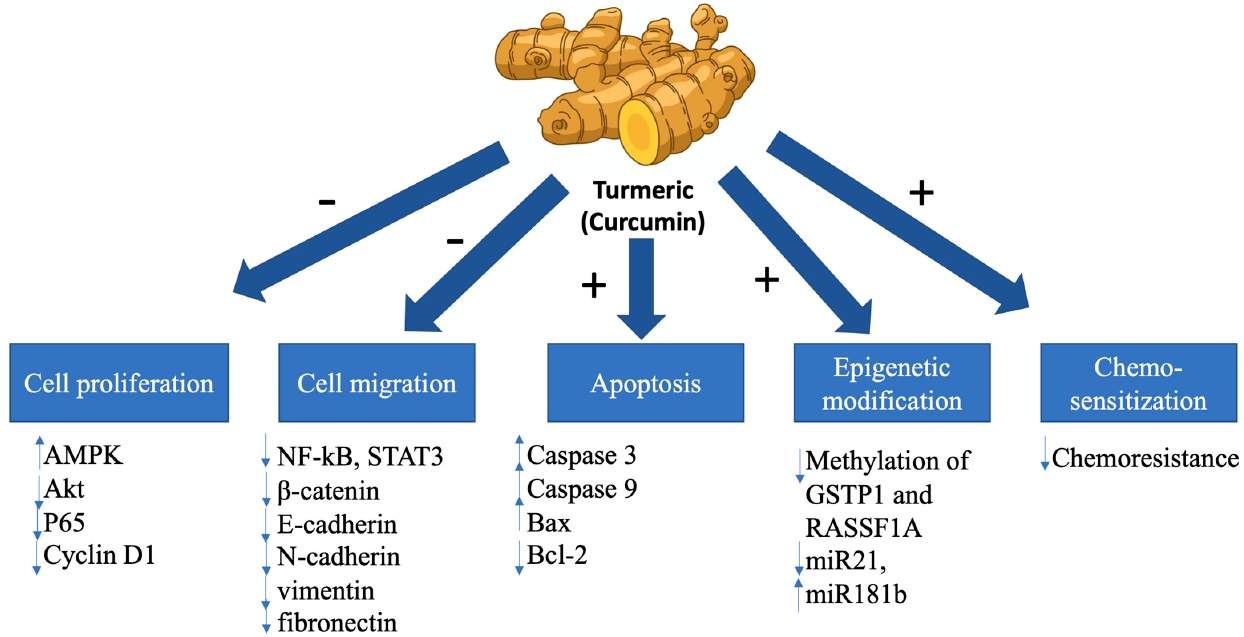
Figure 5. Influence of Curcumin on breast cancer cells. Legend: Ras-association domain family protein 1A (RASSF1A), glutathione S -transferase Pi 1 (GSTP1), phosphatase and tensin homolog/protein kinase B, AMP-activated protein kinase (AMPK), signal transducer and activator of transcription 3 (STAT3).